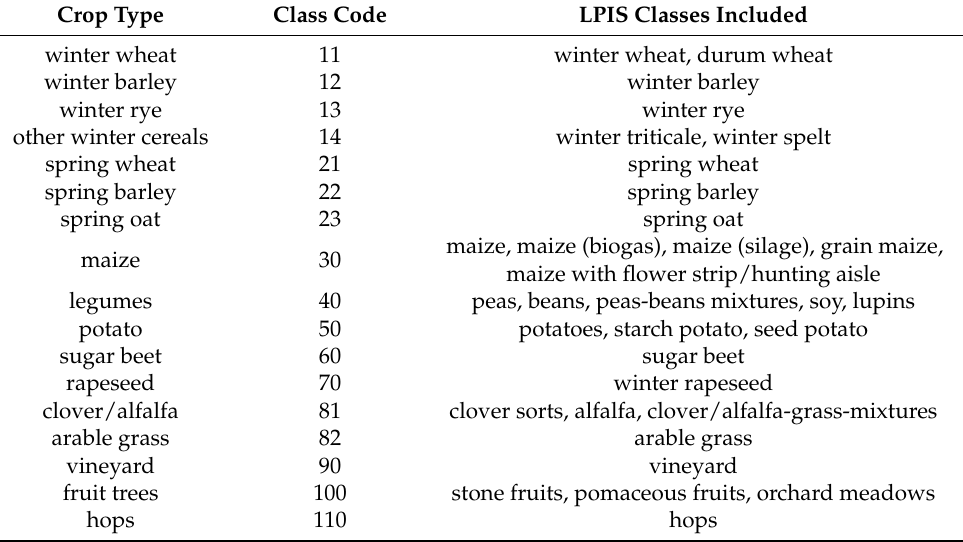
Table 1. Crop types analyzed in this study and their translation from LPIS